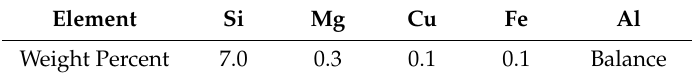
Table 1. Chemical compositions of the A356 alloy powder (wt. %).